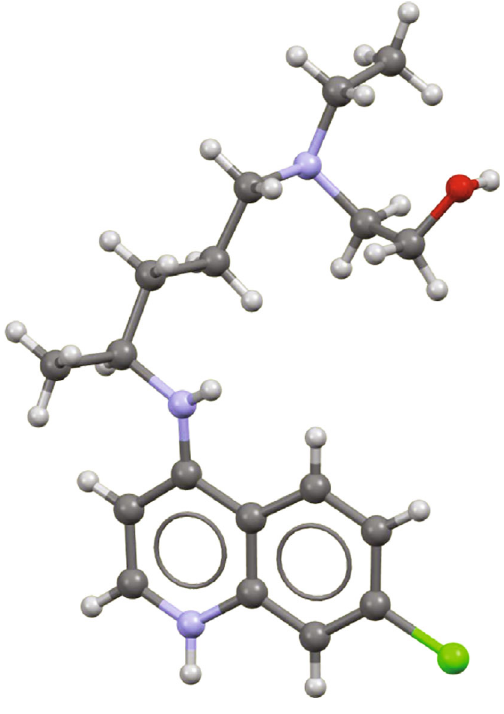
Figure 5: Molecular structure of hydroxychloroquine.